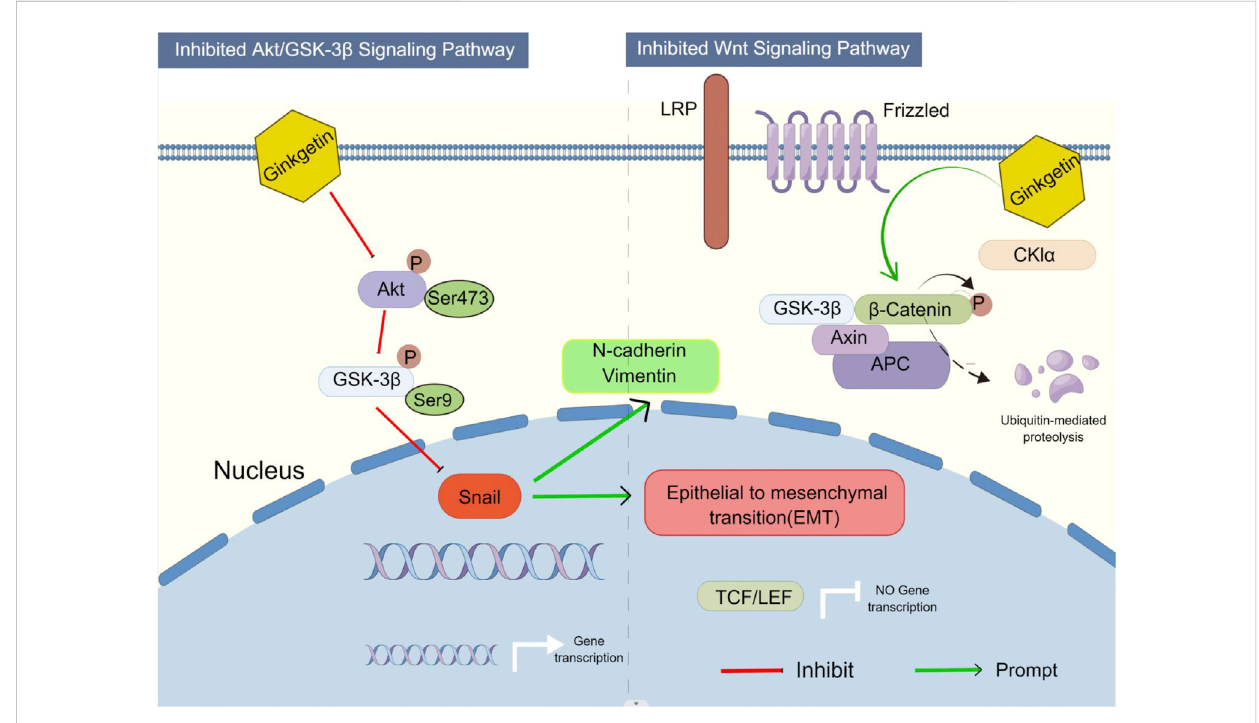
FIGURE 12 Proposed model illustrates how GK inhibits EMT in A549 and H1299 cells via the AKT/GSK-3 β /Snail axis and Wnt/ β -catenin axis (By